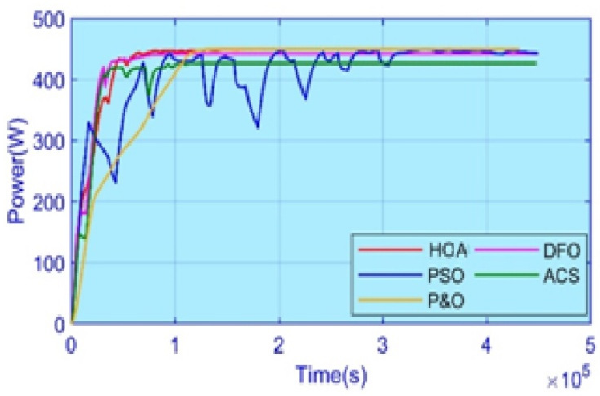
Figure 16. Comparison of the HOA power for Case 2 .